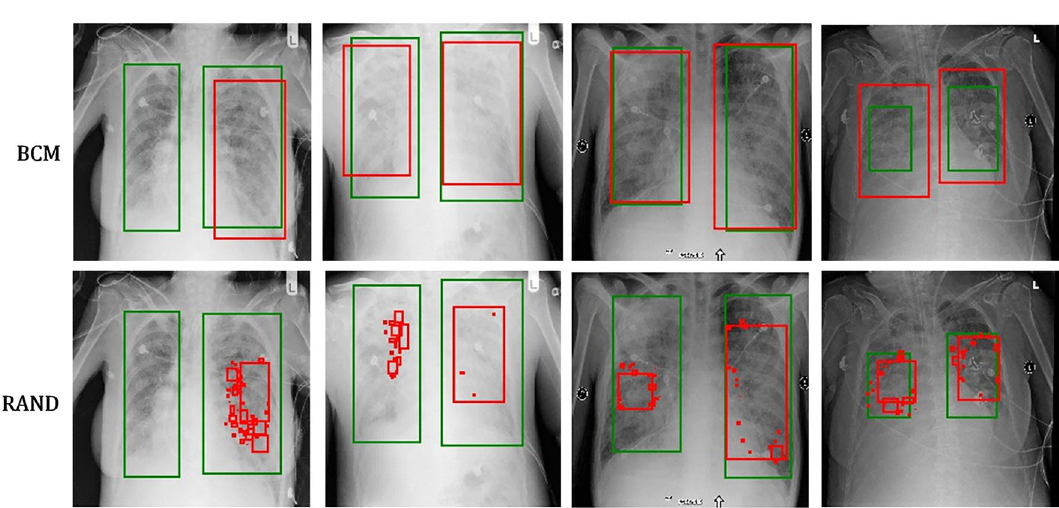
Figure 6. Bounding boxes generated from the batch control method and random models, corresponding to the masks in Fig.